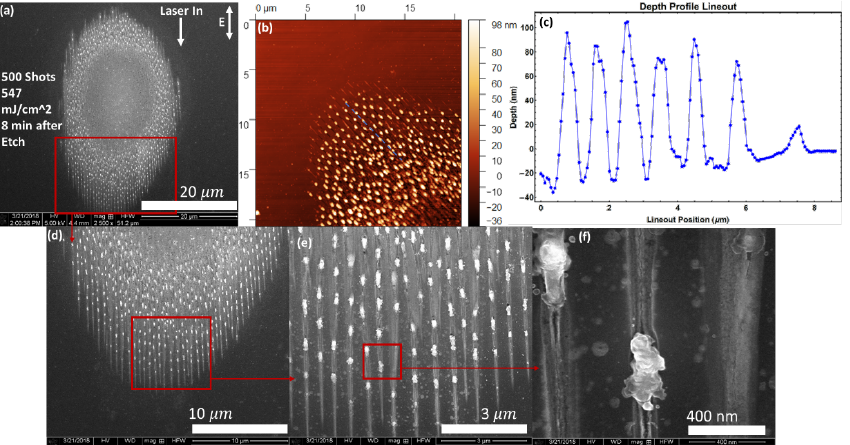
Figure 4. SEM and AFM images of multi-shot LID on silicon (111) with 500 shots, with oxide layer etched 8 min prior to exposure. ( a ) indicates the fluence used and the direction of laser input with polarization both projected onto the sample surface; ( b ) shows an AFM depth profile of the same sample area as in ( d ), but rotate by approx. 135 degrees clockwise. Samples with structures that may mimic AFM artifacts are purposely rotated to avoid scanning along or perpendicular to nanocracks; ( c ) lineout along the blue dotted line in ( b ); ( d ) shows a zoom-in of the boxed area in ( a ); ( e , f ) show further zoom-ins of this area indicated by the red boxes and